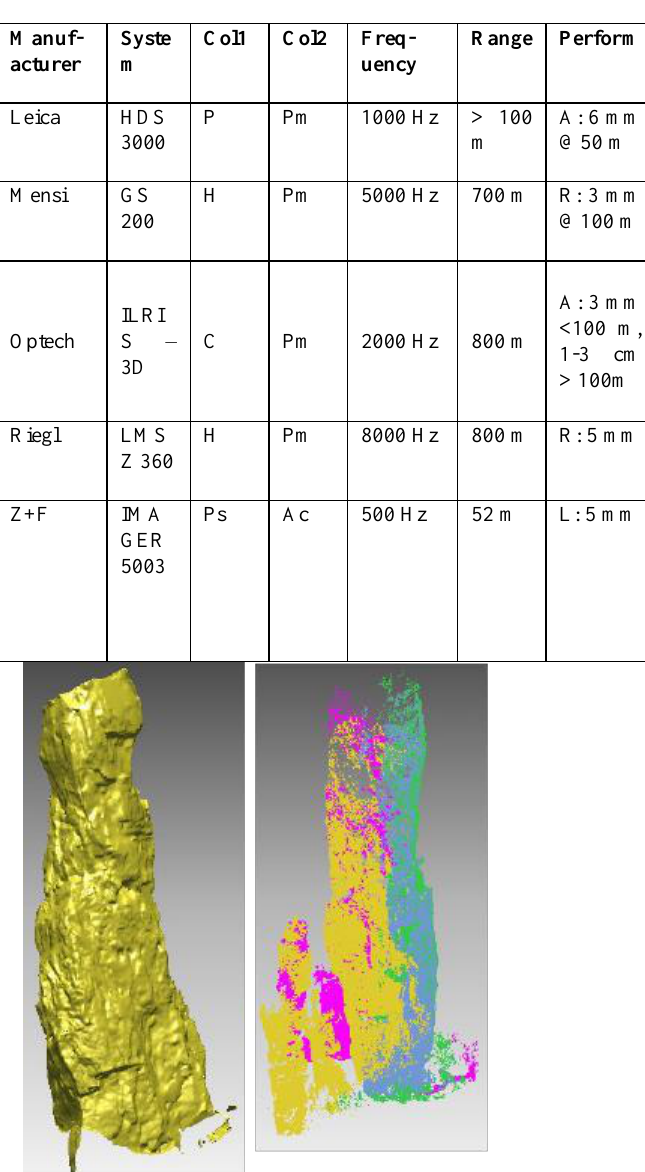
Table 1. Classification of laser scanners